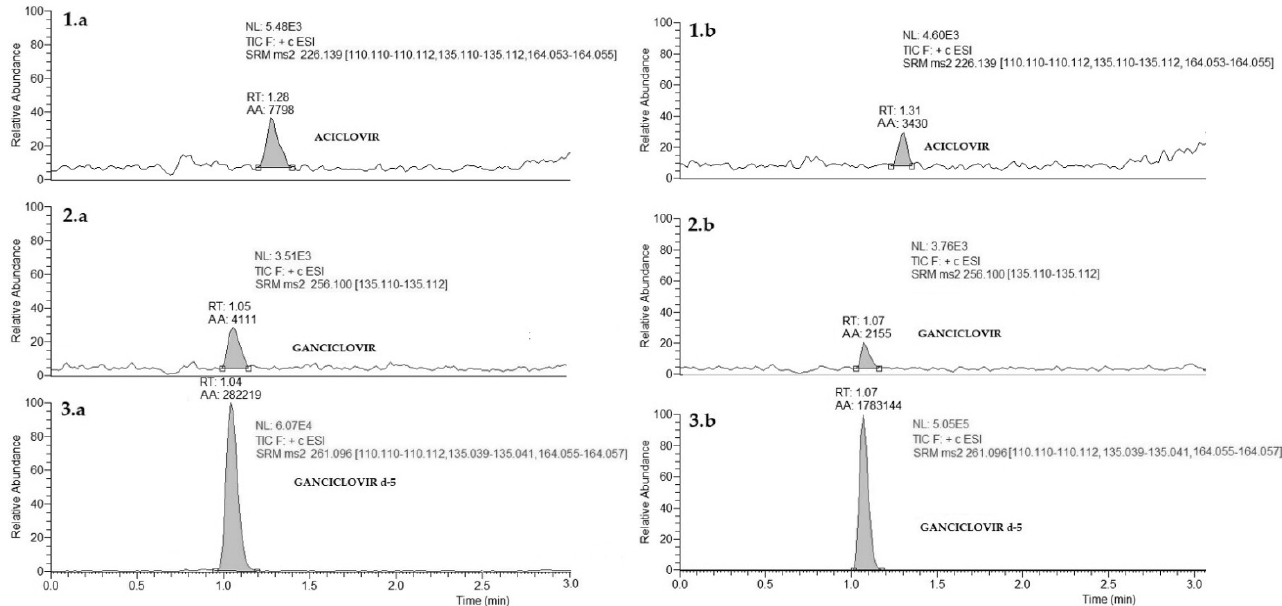
Figure 2. Chromatograms obtained: a calibrator at the LLOQ in plasma (panel 1.a , aciclovir; panel 2.a , ganciclovir); deuterated internal standards (panel 3.a , ganciclovir-d5) and a calibrator at the LLOQ in DPS (panel 1.b , aciclovir; panel 2.b , ganciclovir); deuterated internal standards (panel 3.b , ganciclovir-d5). RT, retention time; AA, automatic area; SN, signal-to-noise ratio; NL, normalized level.